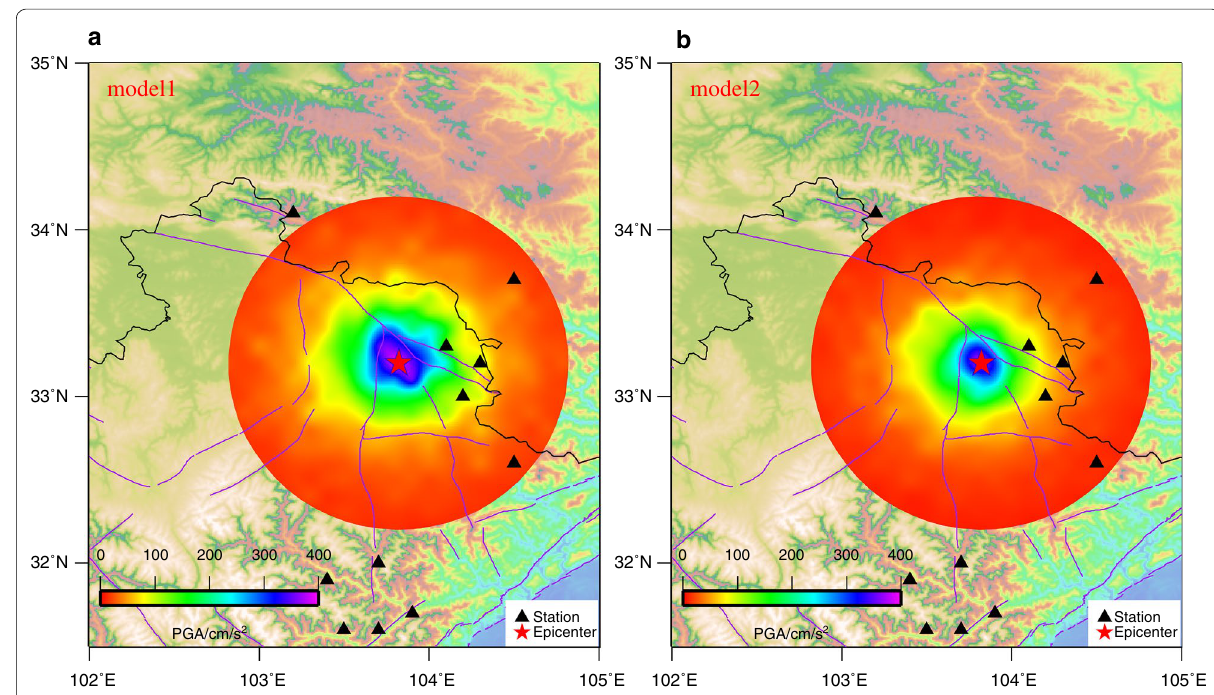
Fig. 10 a Spatial distribution of simulated PGAs from slip model 1. b Spatial distribution of simulated PGAs from slip model 2. The red solid star is the epicenter, and the black triangles represent seismic